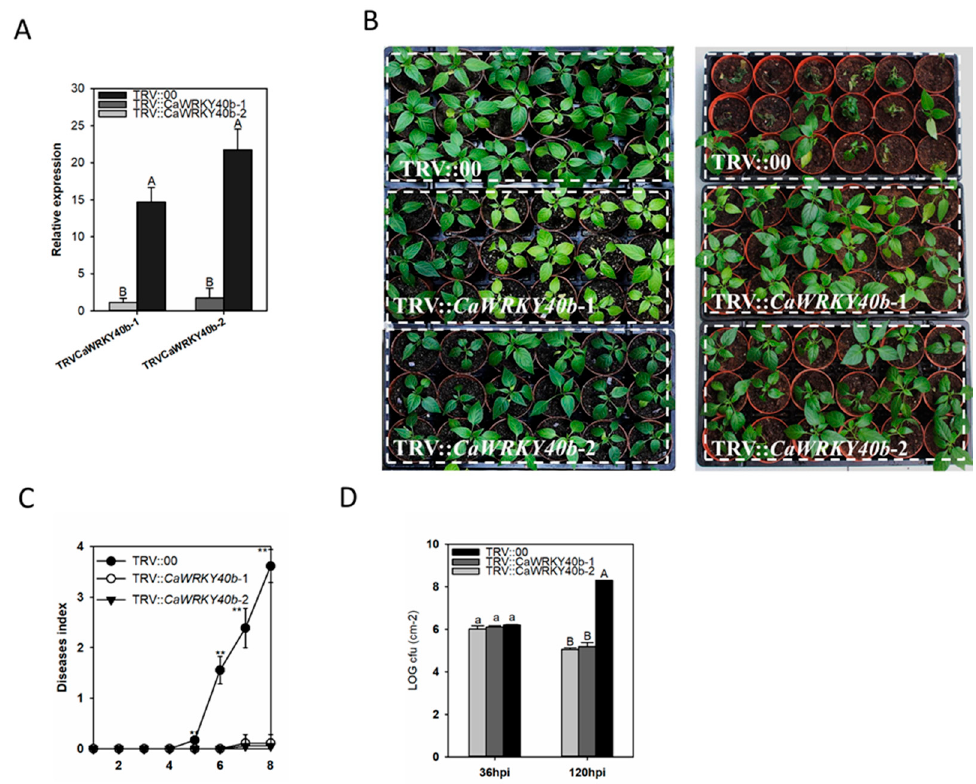
Figure 3. Responses of CaWRKY40b -silenced pepper plants to Ralstonia solanacearum inoculation. ( A